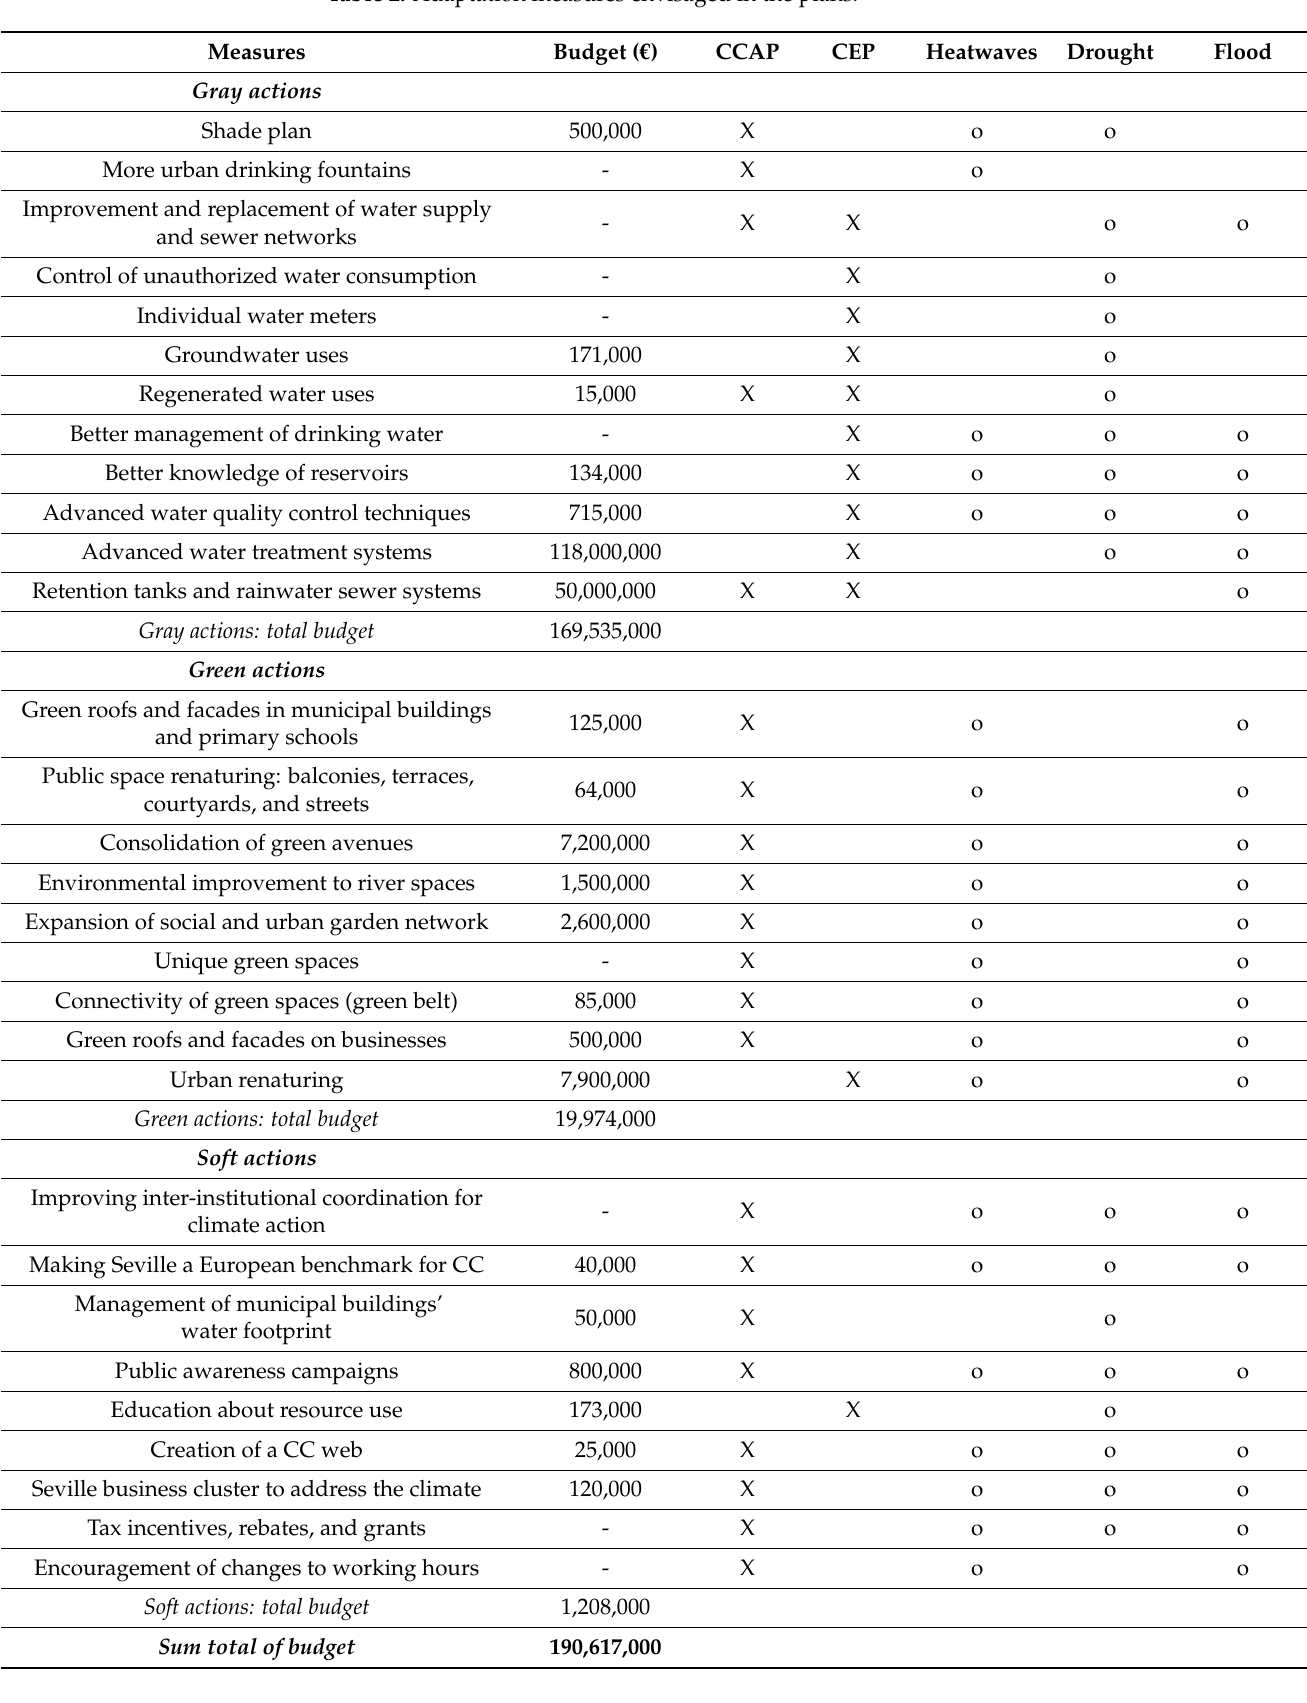
Table 2. Adaptation measures envisaged in the